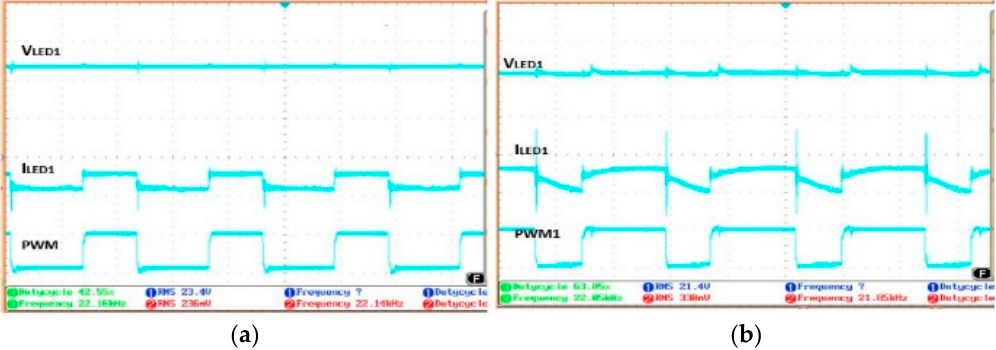
Figure 12. LED voltage and current at duty cycles of ( a ) 42.55% and ( b ) 63% with corresponding gate pulse for string 1.